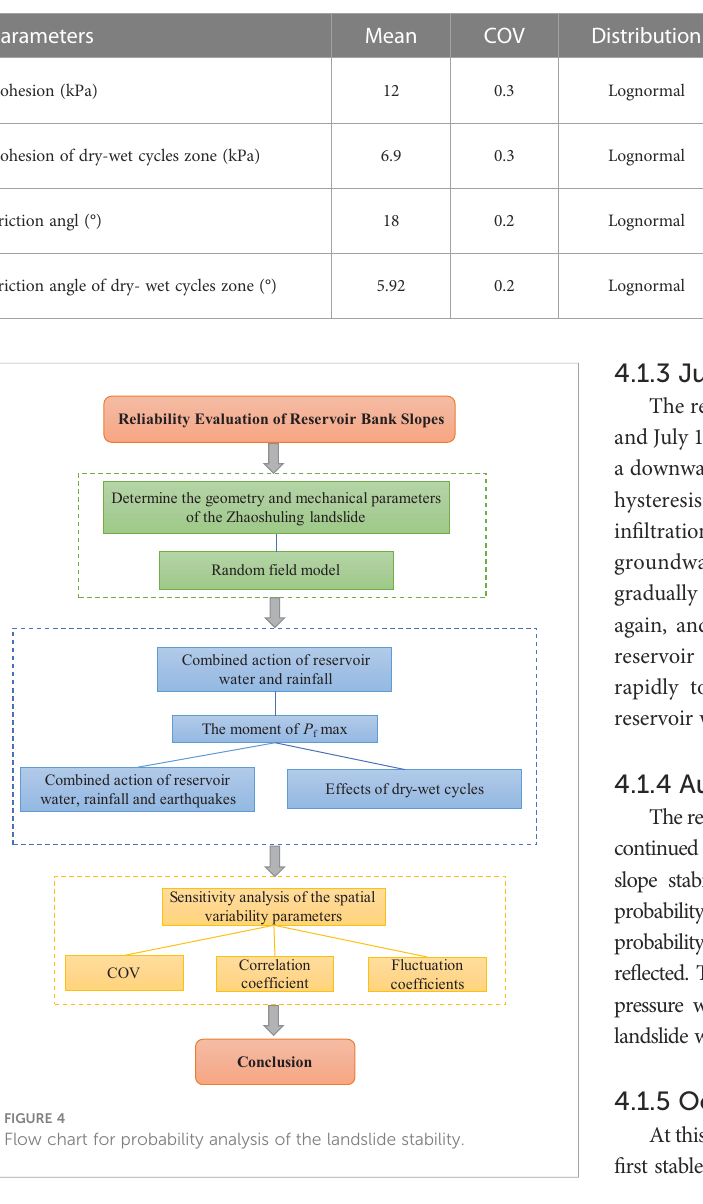
TABLE 3 Statistical mechanical parameters of weak interlayer.